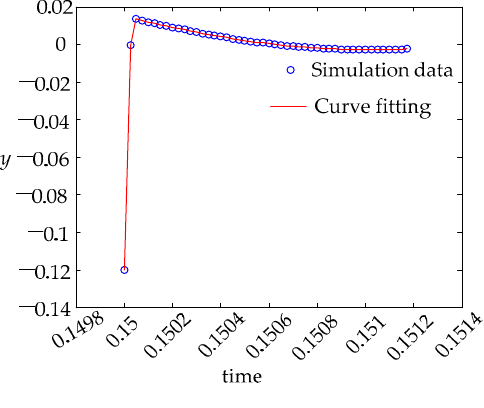
Figure 19. Curve fitting results.